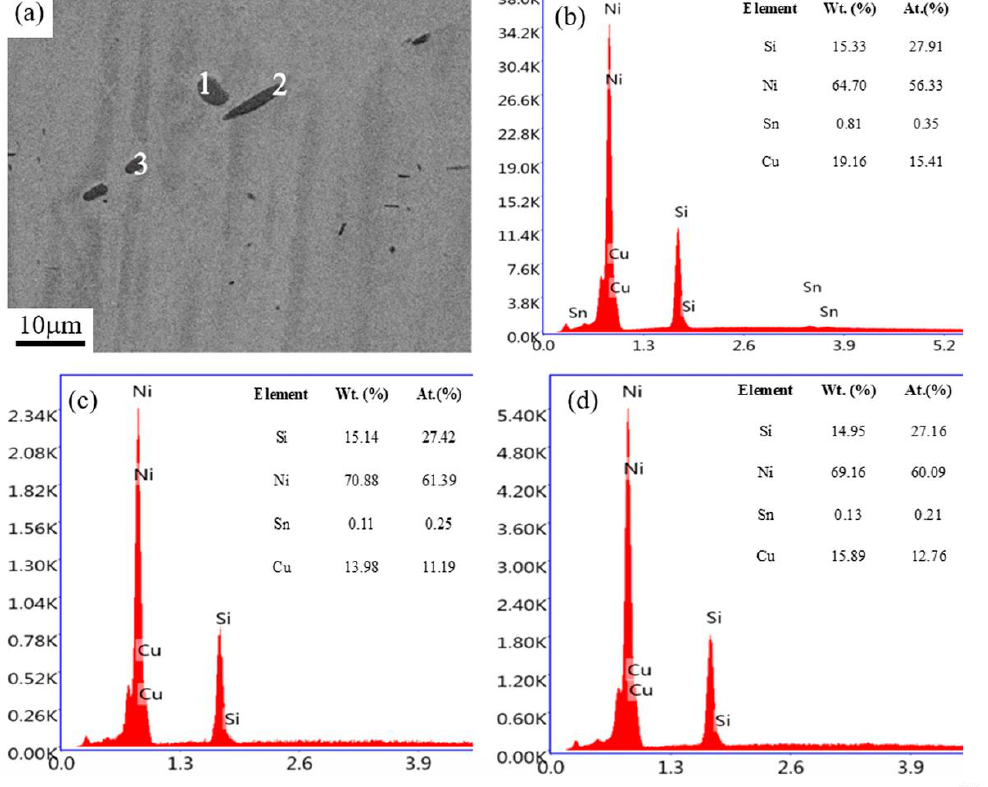
Figure 8. The SEM images ( a ) and EDS results of the as-cast sample of the Cu–6Ni–6Sn–0.6Si alloy: ( b ) point 1 ( c ) point 2 ( d ) point 3.